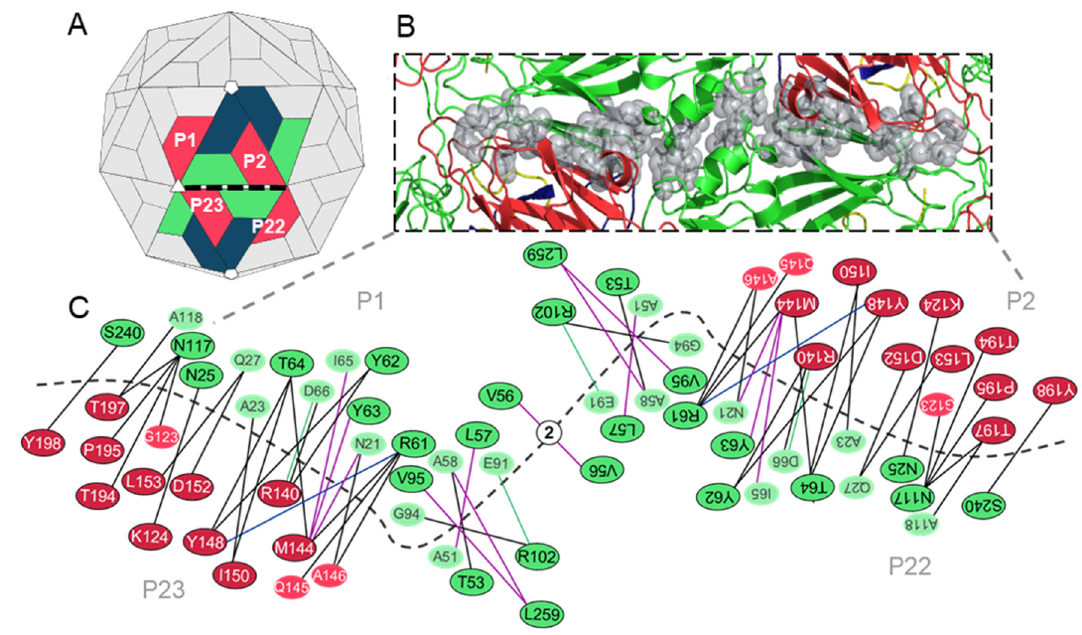
Figure 7. Schematic network of hotspot residues and their interacting partners at the interpentamer interfaces of the TMEV GDVII capsid. ( A ) Structure of the picornavirus capsid showing four protomers from two pentamers that form the interpentamer interface (dashed black line). ( B ) Structural cartoon mapping of predicted hotspot residues (shown as grey spheres) at the interpentamer interfaces. ( C ) Network of hotspot residues and the contacts made with their residue binding partners at the interpentamer interface. Hotspot residues are outlined in black; partner non-hotspots are not outlined. VP1 residues (blue); VP2 residues (green); VP3 residues (red); VP4 residues (yellow). Noncovalent interactions between hotspots and partners are shown as solid lines: hydrogen bonds (black lines); hydrophobic (purple lines); cation–pi (blue lines); and ionic (green lines) interactions.